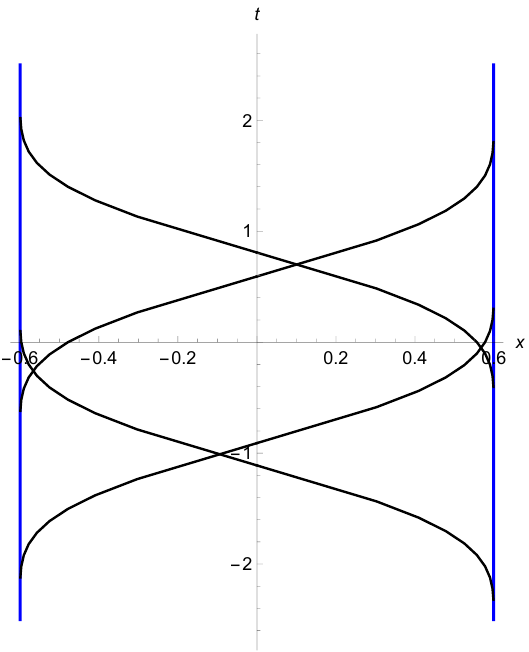
Figure 3 . Few sample light rays (black curves) in the worldsheet (3.1). Here x and t are in the unit of z 0 . Two vertical lines (blue) are trajectories of quark and anti-quark. Light rays emitted from one quark reach the other in some finite times. So two quarks are causally